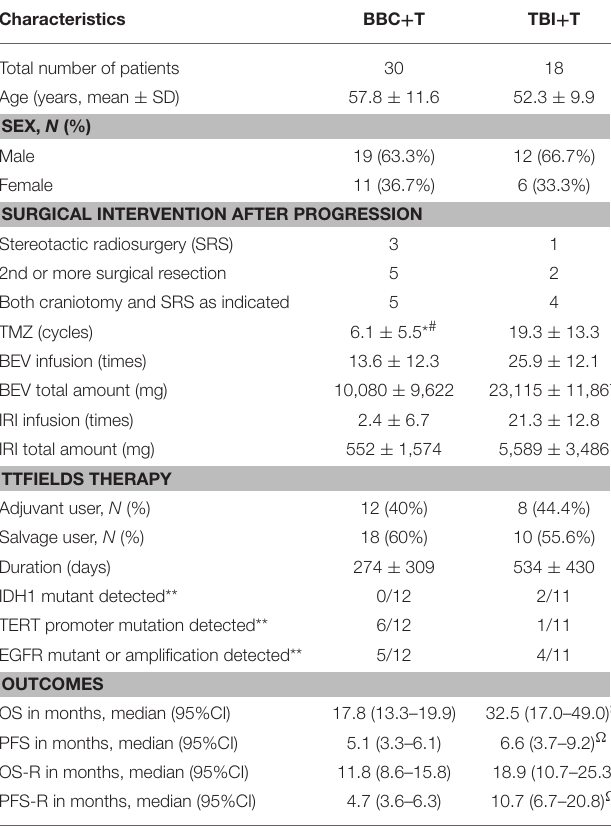
TABLE 1 | Baseline demographics, clinical treatment received and